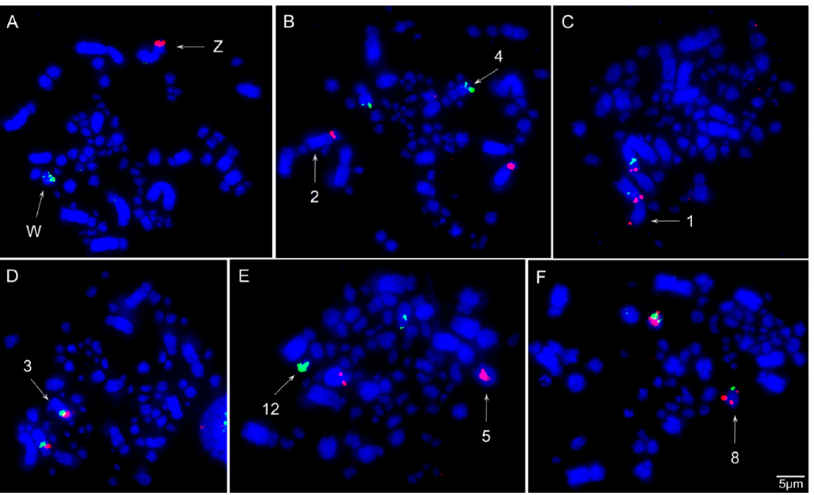
Figure 3. Representative FISH experiments using chicken (CH261) and zebra finch (TGMCBA) macrochromosomes BAC probes in Sicalis flaveola : ( A ) chicken macrochromosome Z TGMCBA ‐ 270I9 (red) and CH261 ‐ 94E12 (green); ( B ) chicken macrochromosome 1 TGMCBA ‐ 146O14 (red) and TGMCBA ‐ 206D5 (green); ( C ) chicken macrochromosome 2 TGMCBA ‐ 340P4 (red) and TGMCBA ‐ 78C11 (green); ( D ) chicken macrochromosome 3 CH261 ‐ 130M12 (red) and CH261 ‐ 97P20 (green); ( E ) chicken macrochromosome 4 CH261 ‐ 89P6 (red) and CH261 ‐ 71L6 (green); ( F ) chicken macrochromosome 7 CH261 ‐ 180H18 (red) and CH261 ‐ 56K7 (green).